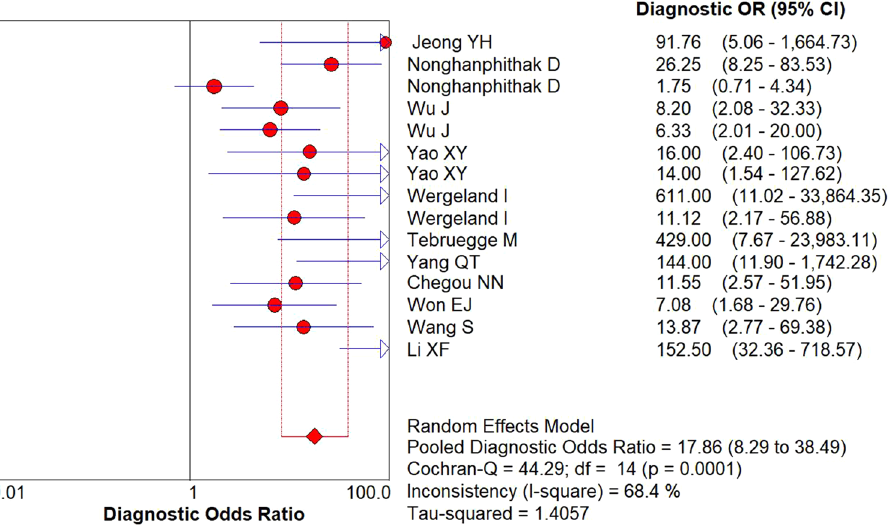
Figure 4. Forest plots of diagnostic odds ratio (DOR) of IP-10 for differentiating ATB from LTBI. The pooled DOR was 17.86 (95% CI: 2.89–38.49, I 2 = 68.4%).